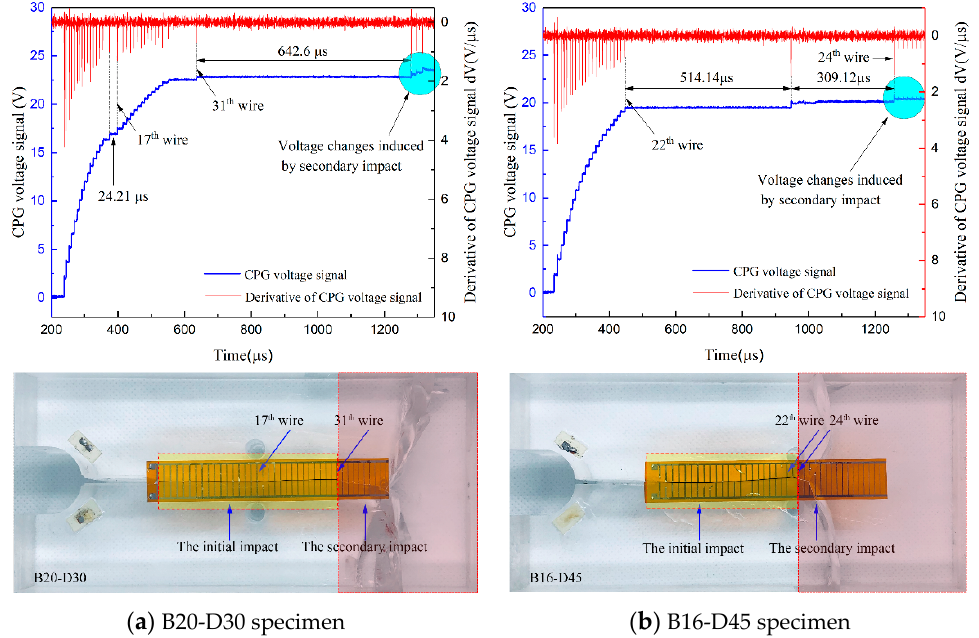
Figure 5. Crack fracture patterns of the specimens. ( a ) Crack pattern of the B12-D15 specimen. ( b ) Crack pattern of the B12-D30 specimen. ( c ) Crack pattern of the B12-D45 specimen. ( d ) Crack pattern of the B16-D15 specimen. ( e ) Crack pattern of the B16-D30 specimen. ( f ) Crack pattern of the B16-D45 specimen. ( g ) Crack pattern of the B20-D15 specimen. ( h ) Crack pattern of the B20-D30 specimen. ( i ) Crack pattern of the B20-D45 specimen.